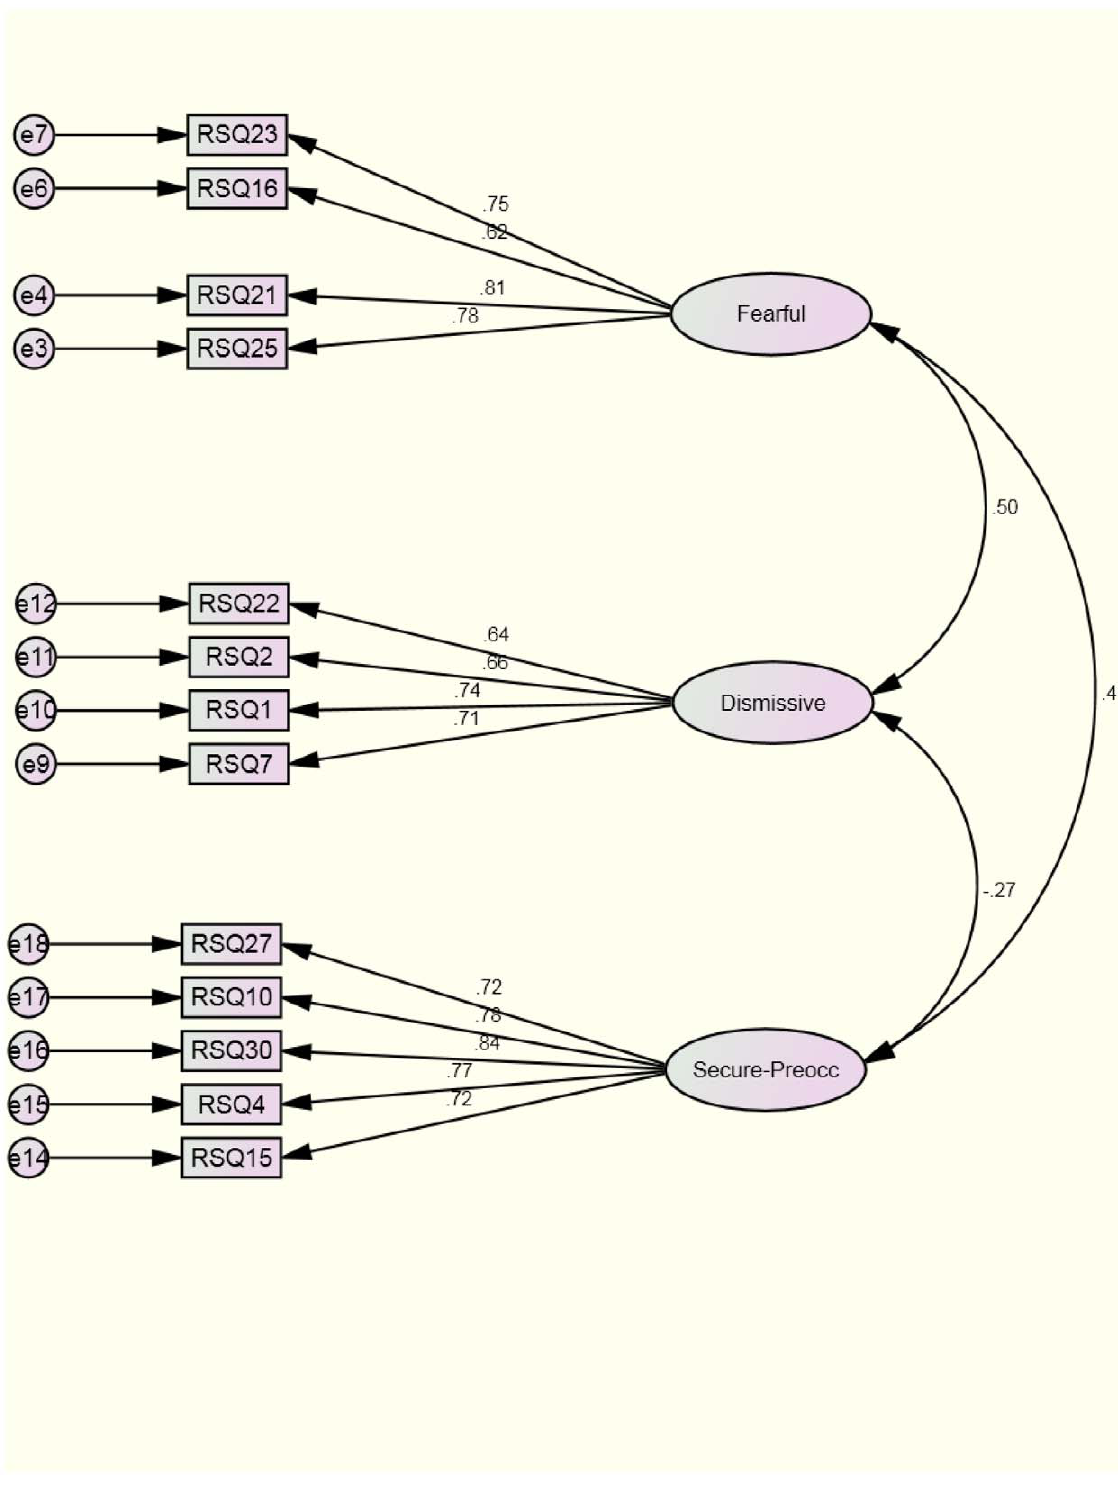
Figure 4. Confirmatory factor analysis model of the latent nation attachment constructs in Study 2. doi:10.1371/journal.pone.0053872.g004 The pattern of intercorrelation between the three nation attachment styles was replicated from the first study. We reconstructed the hierarchical linear model from Study 1 to investigate the association of nation attachment with heritage